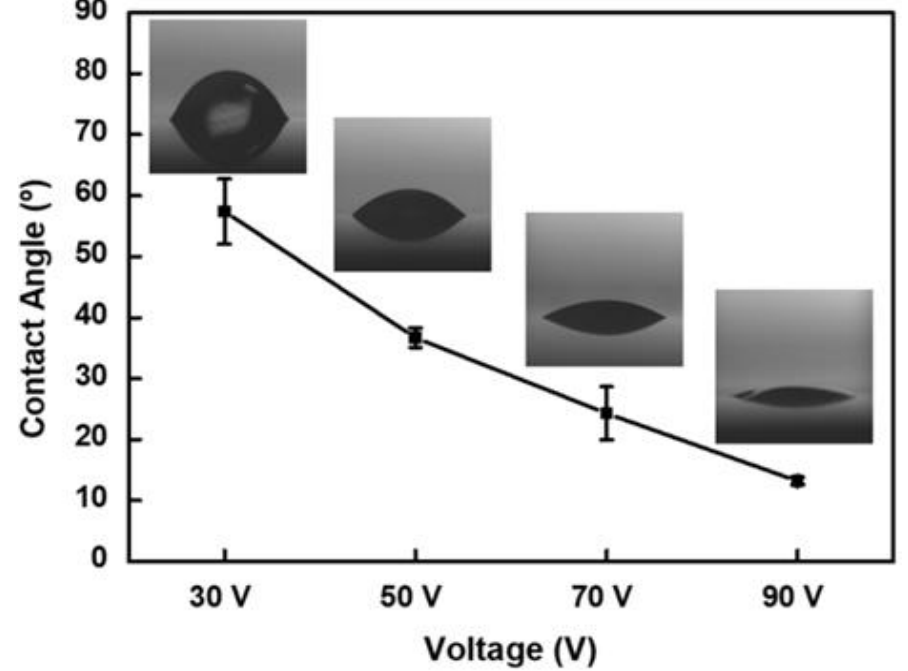
Figure 4. Contact angles before FDTS was coated on the anodized stainless steel 316L samples, at applied voltages of 30, 50, 70, and 90 V.